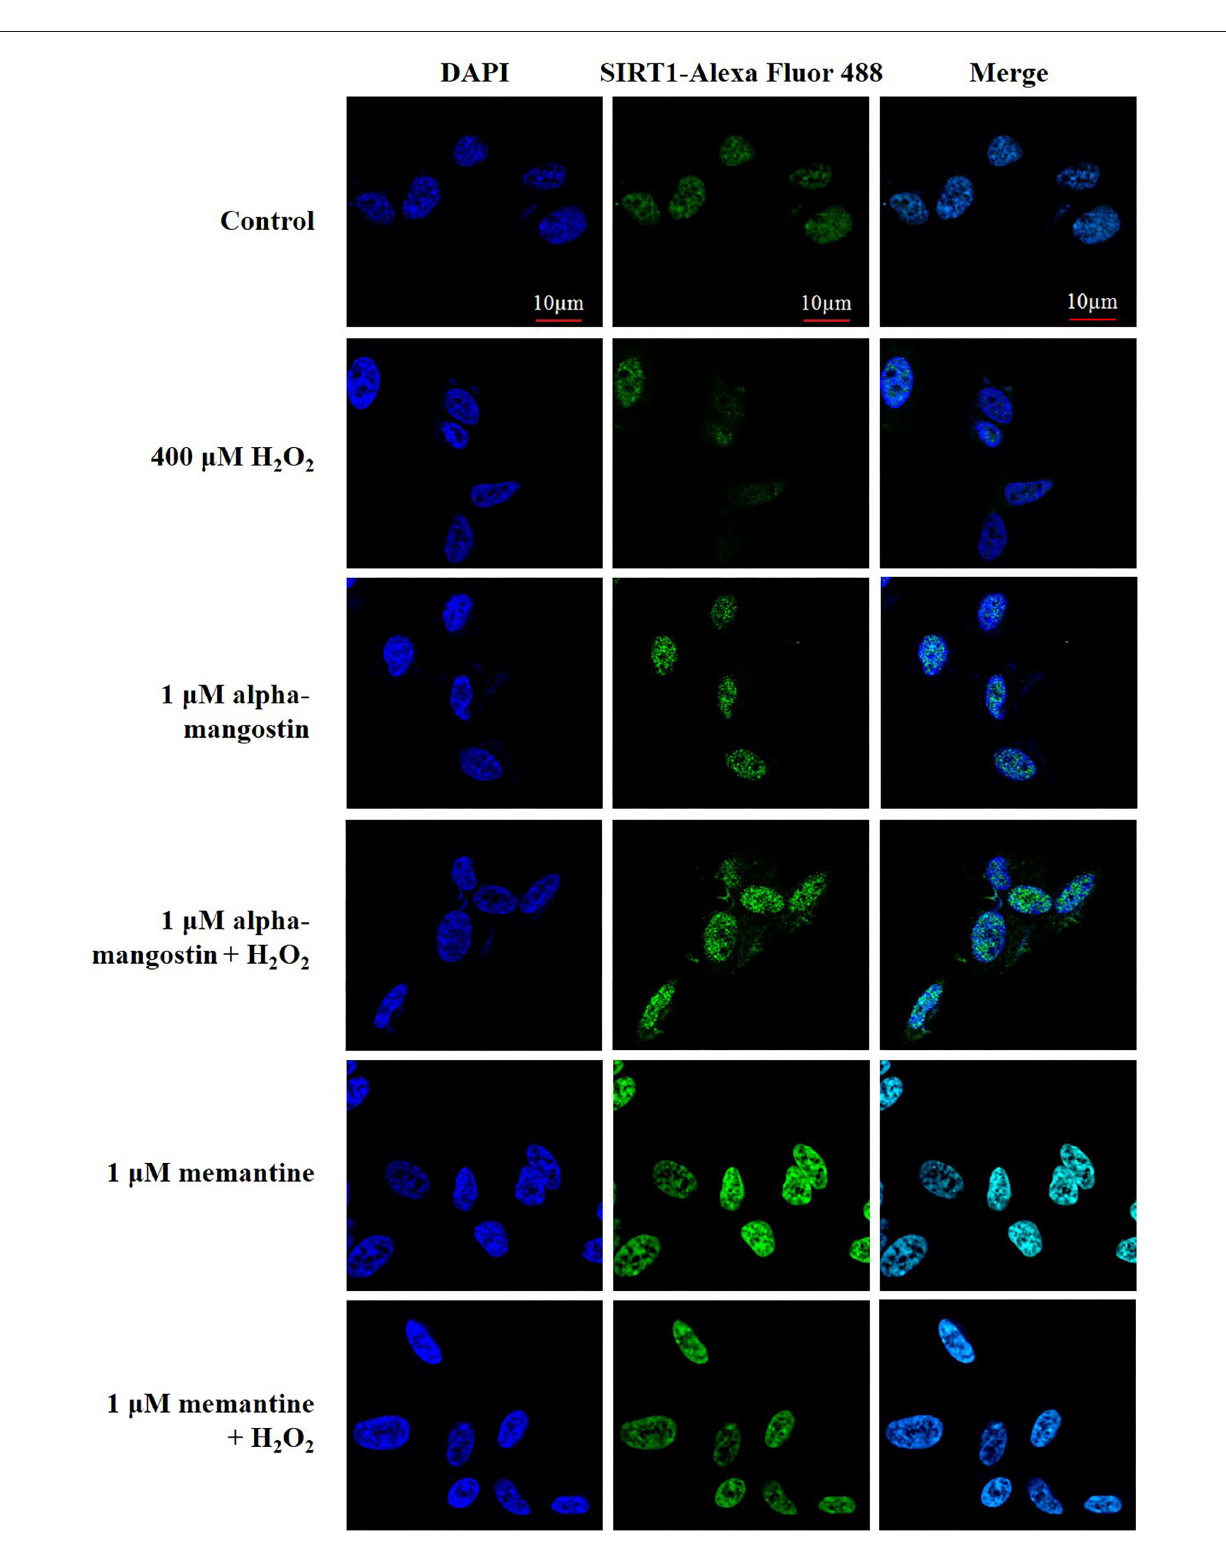
Frontiers in Nutrition |